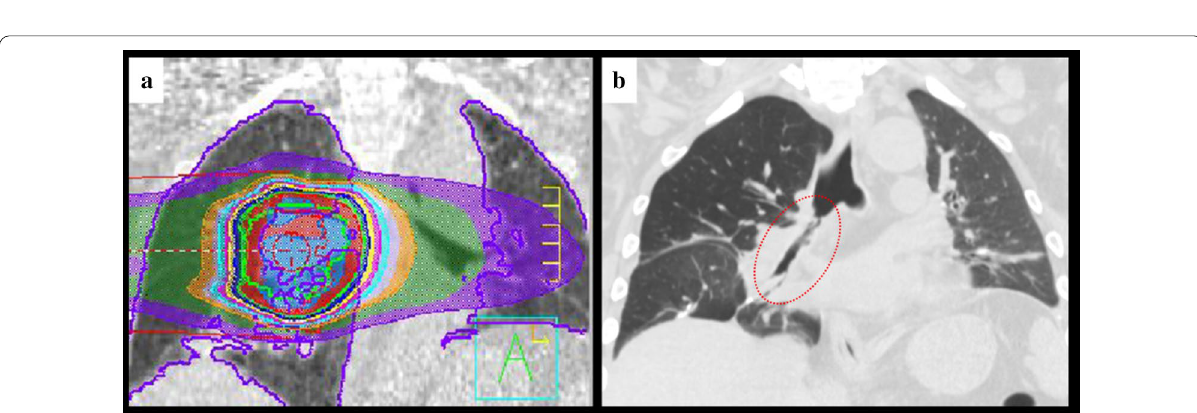
Fig. 2 Coronal images of computed tomography before and after radiotherapy. a Radiation range shown with a coronal plane. b A coronal view showing the wide range of bronchial stenosis, indicating right bronchial wall thickening and narrowing of the bronchial lumen (red interrupted